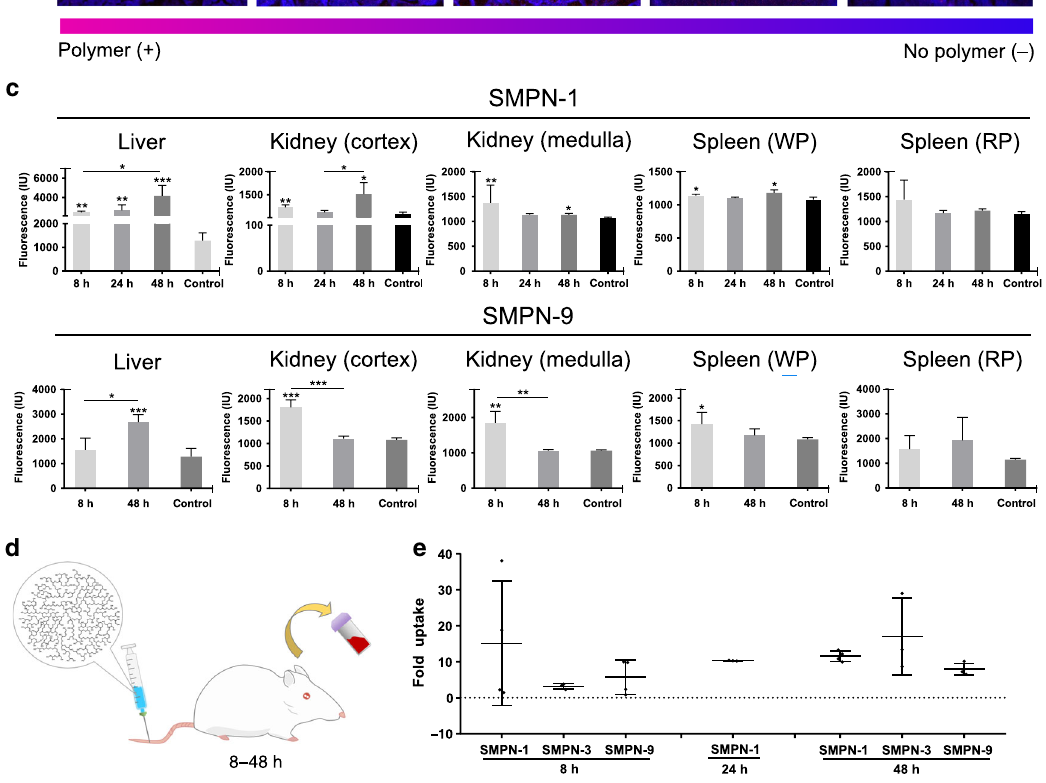
took snapshots of protein composition on SMPN-1 at 8, 24, and 48 h, with as limited as 0.001% relative total protein content detected on its bio-interface. Within the group, correlation ana- lysis of the biological replicates performed in Perseus software demonstrated good replicate correlation as depicted in the binary scatterplots and LFQ intensity histograms